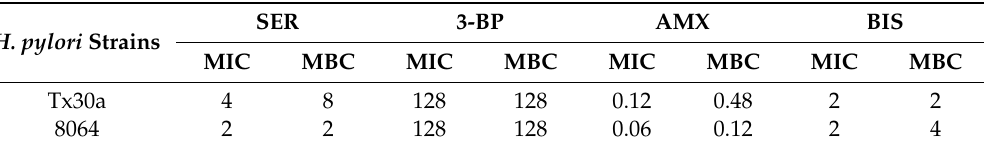
Table 1. MICs and MBCs of amoxicillin (AMX), bismuth subsalicylate (BIS), sertraline (SER), and 3-bromopyruvate (3-BP) against H. pylori Tx30a and 8064 strains. H. pylori Strains